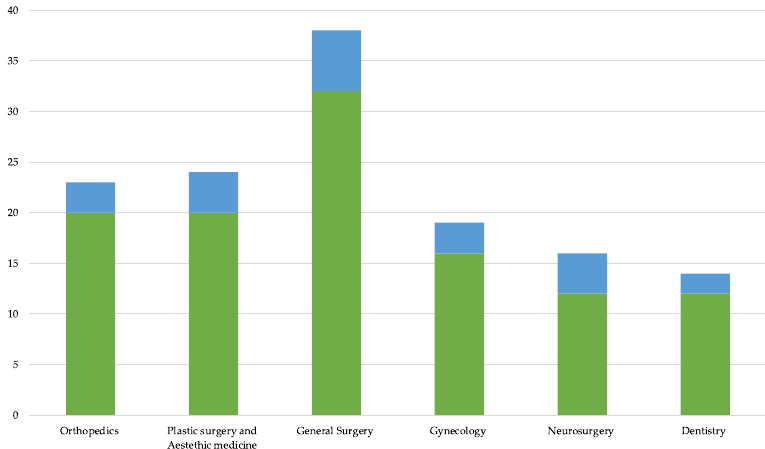
Figure 3. Number of causes (green) divided per branch and related convictions (blue).